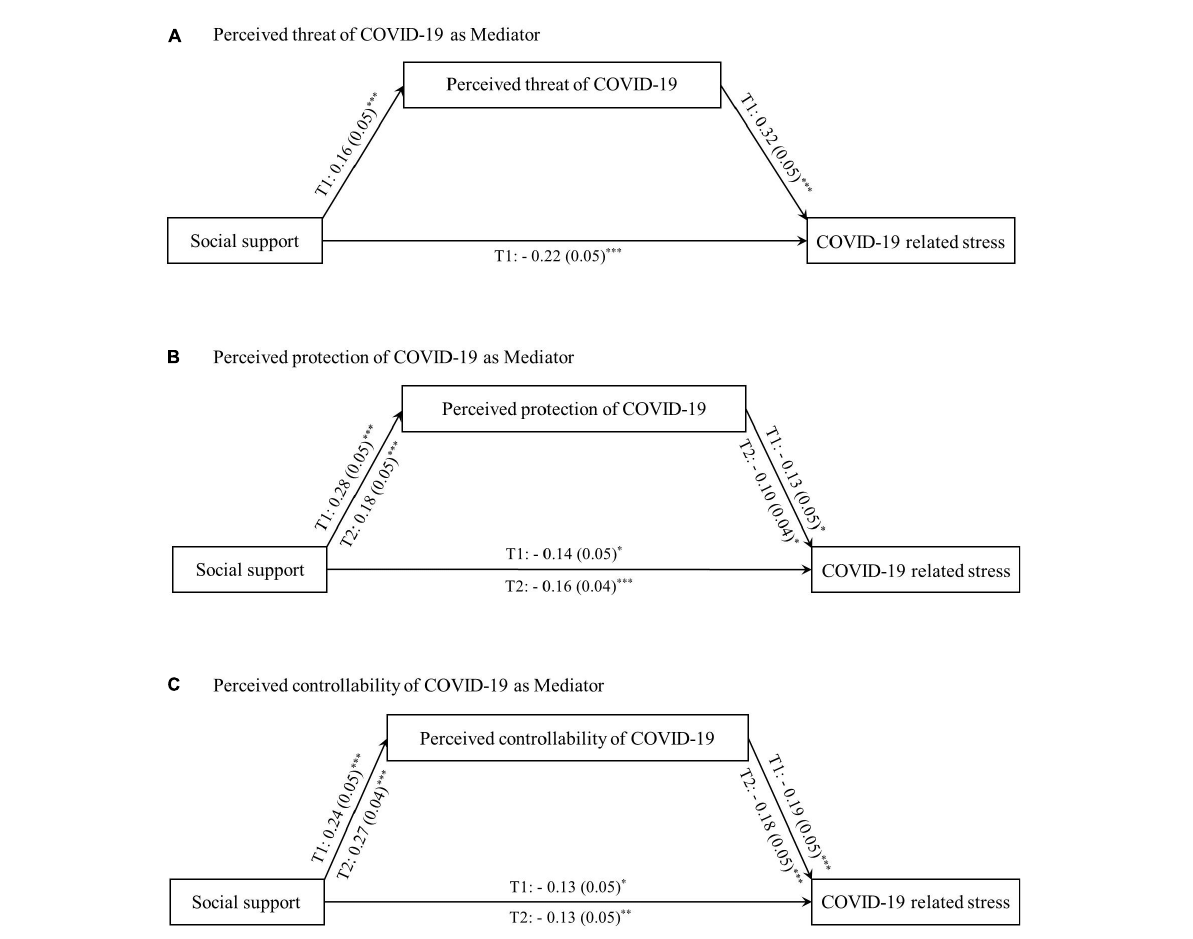
FIGURE3 The mediation of perceived threat, perceived defense, and perceived controllability during the first wave of the COVID-19 outbreak and one year later. The link between social support and COVID-19 related stress is mediated. Path values are the path coefficients (standard errors). All covariates (whether in one-child family, education, age, gender, career, and income) were controlled in the analysis. T1 is the first wave of the outbreak; T2 is the second wave of 1 year after the first wave. (A) Shows that the perceived threat of COVID-19 mediates the relationship between social support and COVID-19 related stress in T1, but not in T2. (B) Shows that the perceived protection of COVID-19 mediates the relationship between social support and COVID-19 related stress both in T1 and T2. (C) Shows that the perceived controllability of COVID-19 mediates the relationship between social support and COVID-19 related stress both in T1 and T2. ∗ p < 0.05, ∗∗ p < 0.01, and ∗∗∗ p <